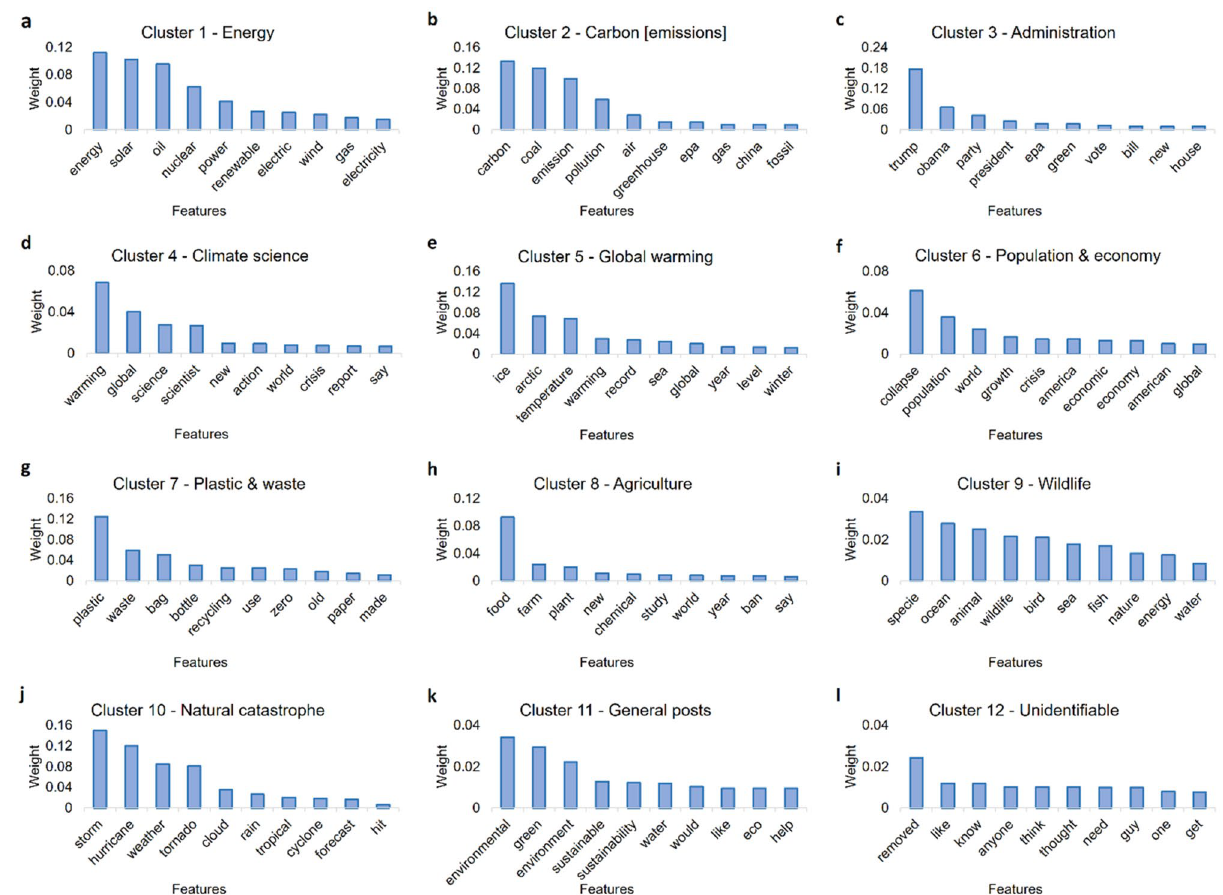
Figure 6. Showing the underlying features driving the discussions within the optimized clusters obtained for Sample 2. The underlying features are obtained by training a supervised learning-based Random forest binary classifier. From the output, we observe that all the clusters are composed of discussions related to unique themes and sub-themes within them. For instance, we obtain features such as solar, oil, nuclear, etc. in Energy